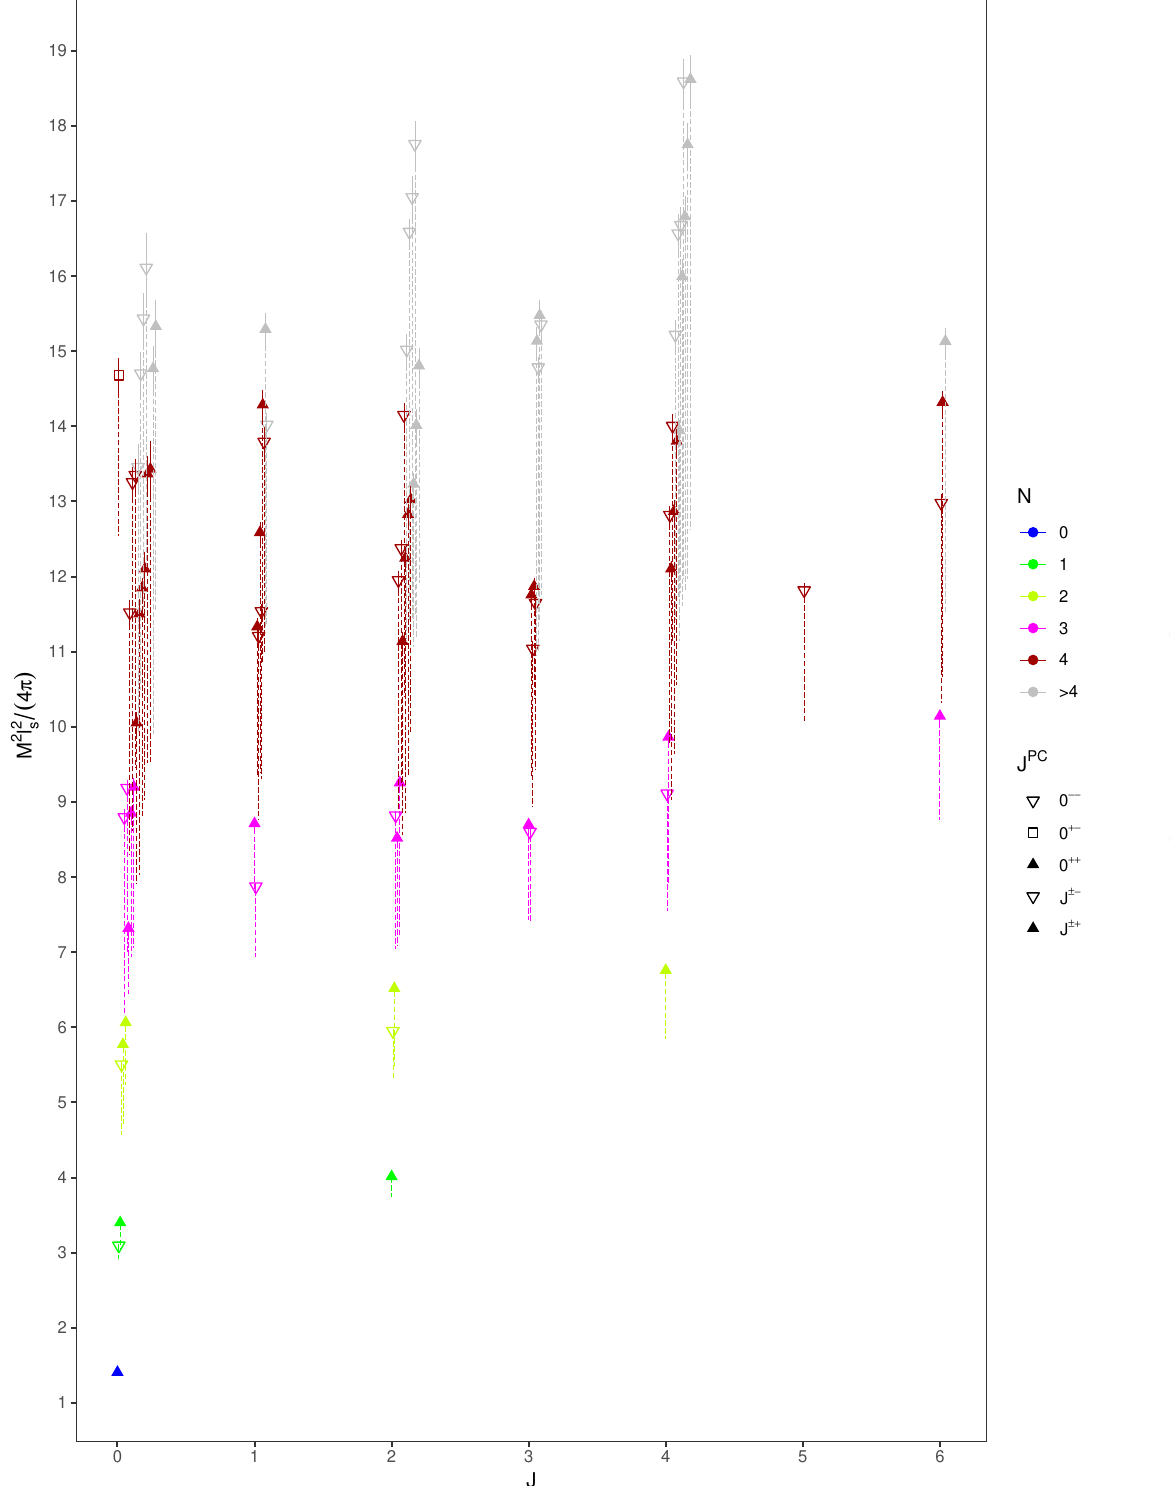
Figure 10. Glueball spectrum with AR masses. Dotted bars extend till the corresponding con- ventional mass value.